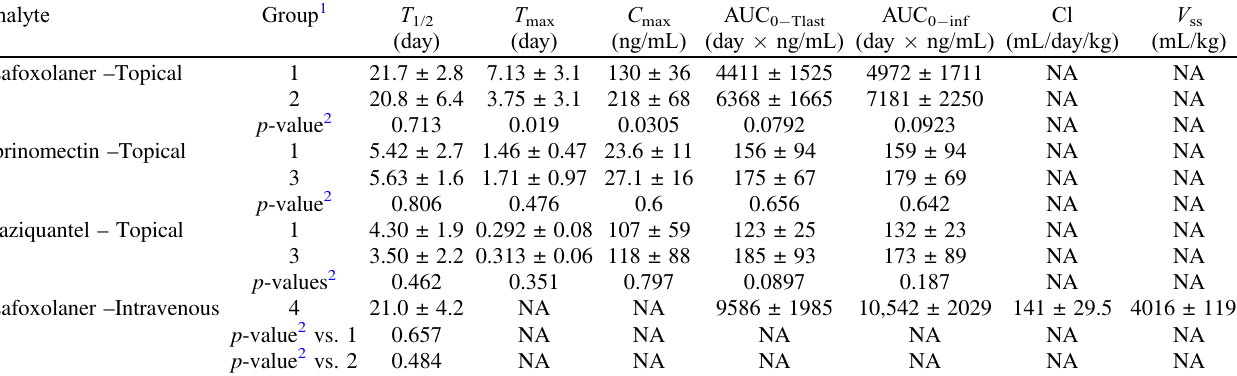
Table 2. Summary of the pharamacokinetic parameters (mean ± SD ) of esafoxolaner, eprinomectin and praziquantel in NexGard (cid:1) Combo following a single topical application at the minimum recommended dose, of eprinomectin and praziquantel in Broadline (cid:1) , and of esafoxolaner alone administered topically or intravenously.